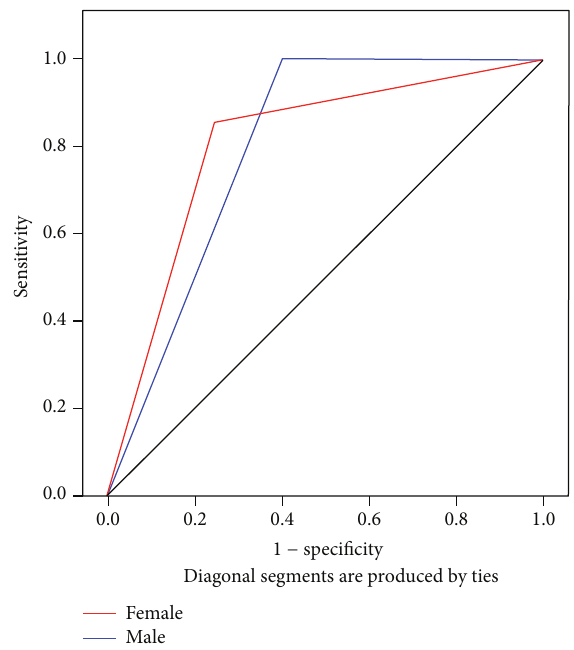
Figure 4: Receiver operating characteristic (ROC) curves of serum leptin and delayed puberty in 𝛽 -TM patients with cut-off vales mentioned in the text. The red and blue lines indicate female and male 𝛽 -TM patients, respectively. The AUCs ( ± SE) and 𝑃 values for female and male 𝛽 -TM patients are 0.717 ( ± 0.166), 𝑃 = 0.235 and 0.553 ( ± 0.191), 𝑃 = 0.777 ,